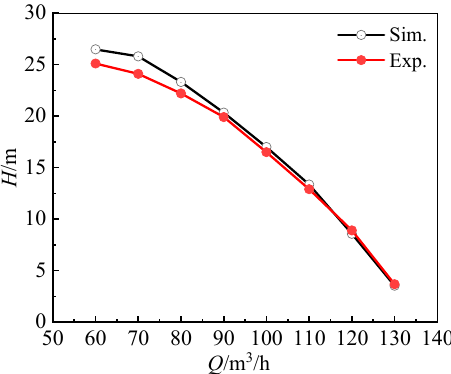
Figure 4. Flow chart of experimental system: ① water tank, ② centrifugal pump, ③ Coriolis mass flowmeter, ④ HAMP test section, ⑤ pressure sensor, ⑥ differential pressure sensor, ⑦ data ac ‐ quisition device, ⑧ computer, ⑨ heat exchanger.